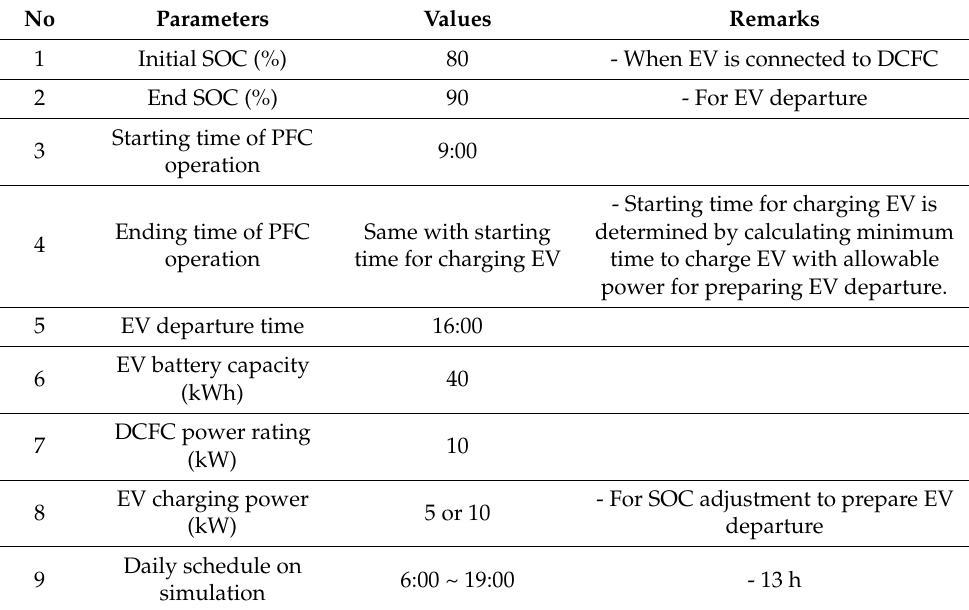
Table 2. Operational conditions and schedule of single-vehicle-based